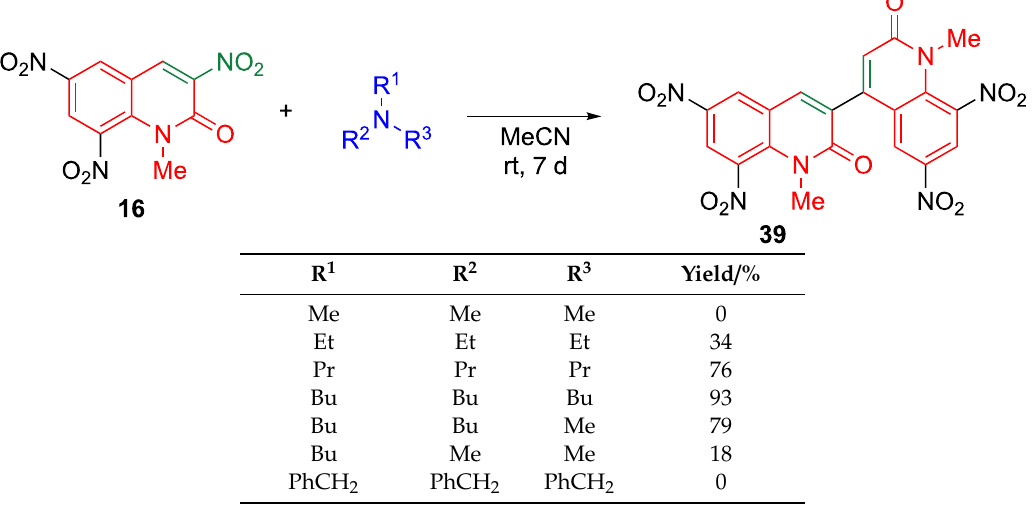
Table 12. Reactions of 16 with tertiary amines.